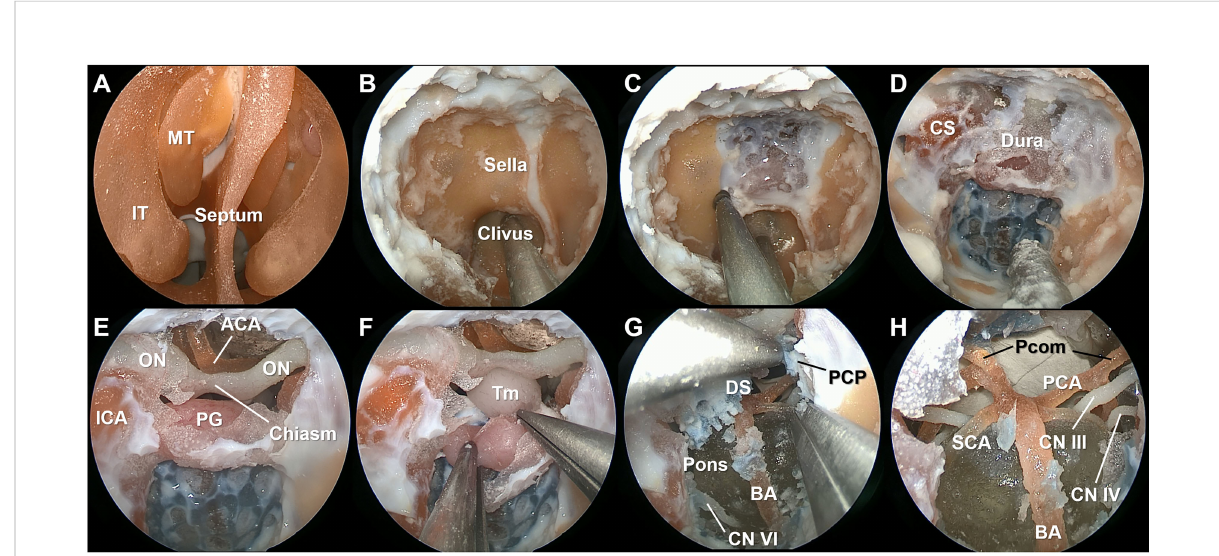
FIGURE 2 Stepwise dissection of the endoscopic endonasal surgery procedures using the simulation model. The mucosa and bony structures of the intranasal cavity were identi fi ed (A) . After wide sphenoidotomy (B) , the anterior skull base was drilled to expose the sella, clivus, and anterior wall of the cavernous sinus (C, D) . The dura ventral to the brain stem was colored in blue to indicate the basilar venous plexus. Intradural neurovascular structures were observed after opening the dura (E) , and the tumor lesion reconstructed from the patient with a stalk originated craniopharyngioma was identi fi ed (F) . After resection of the dorsum sella and posterior clinoid process, neurovascular structures within the posterior fossa were identi fi ed (G, H) . IT, inferior turbinate; MT, middle turbinate; ON, optic nerve; ICA, internal carotid artery; ACA, anterior cerebral artery; PG, pituitary gland; BA, basilar artery; Pcom, posterior communicating artery; PCA, posterior cerebral artery; SCA, superior cerebellar artery; CN, cranial nerve.